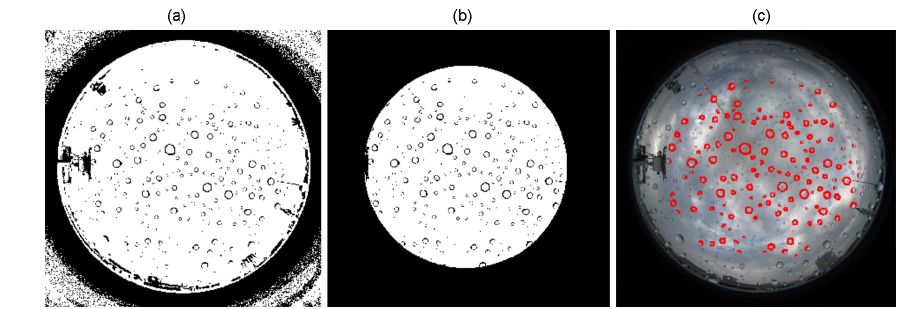
Figure 2. Raindrop detection. From (a) to (c) : binary image, clipped binary image, final raindrop decision image.